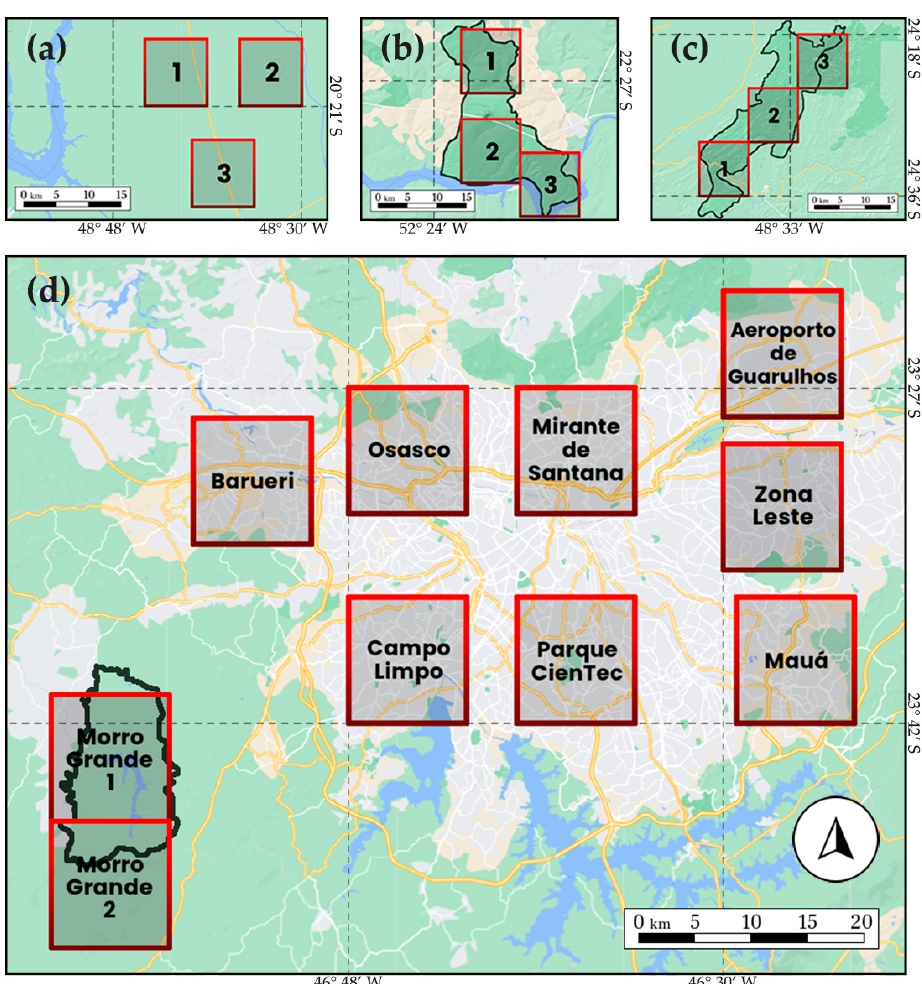
Figure 3. Geographic positioning of the three analysis windows on the NERG ( a ), three on the PEMD ( b ), three on the PETAR ( c ) and ten on the MASP ( d ). Analysis windows are regions that select HCHO columns for more in-depth